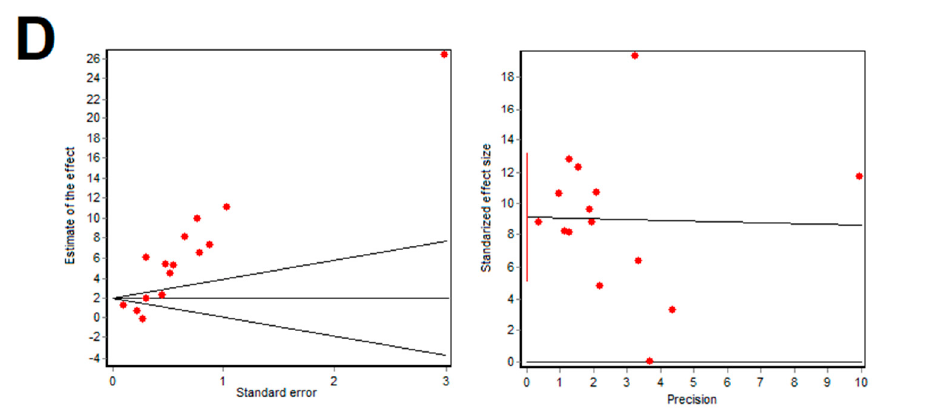
Figure 2. Results from the selected studies. ( A ): Galbraith graph to visualize data heterogeneity; ( B ): Forest chart to visualize robustness of leptin data without obesity; ( C ): Forest chart to visualize robustness of leptin data with obesity; ( D ): Funnel plot graph (left) and Egger’s regression plot (right) to visualize asymmetry [24–38].